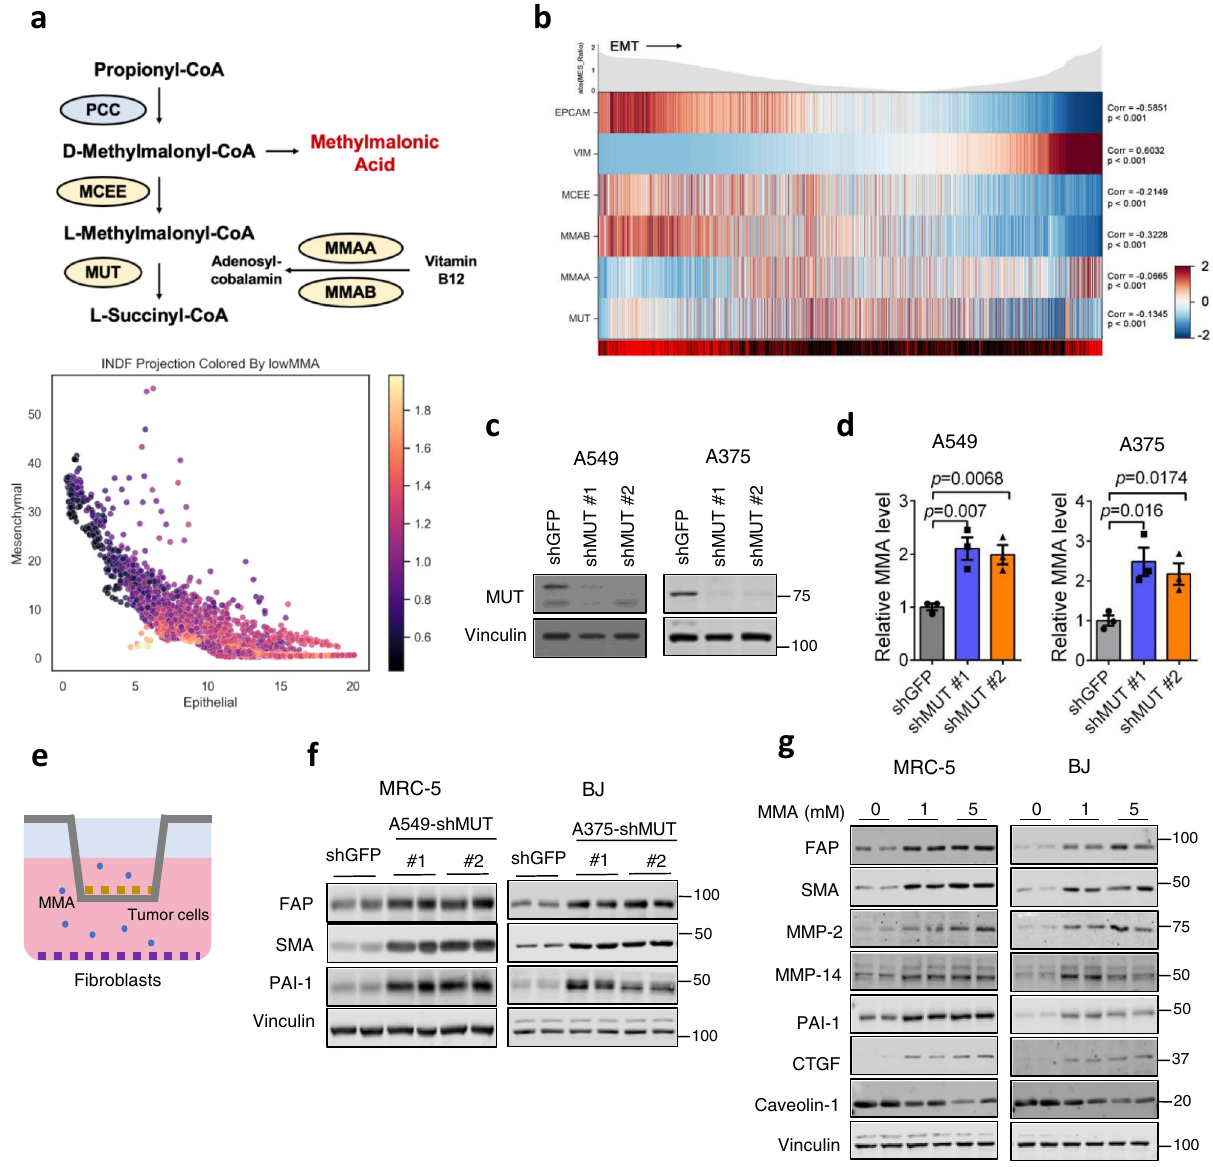
Fig. 1 | MMA produced by tumor cells promotes a cancer-associated fi